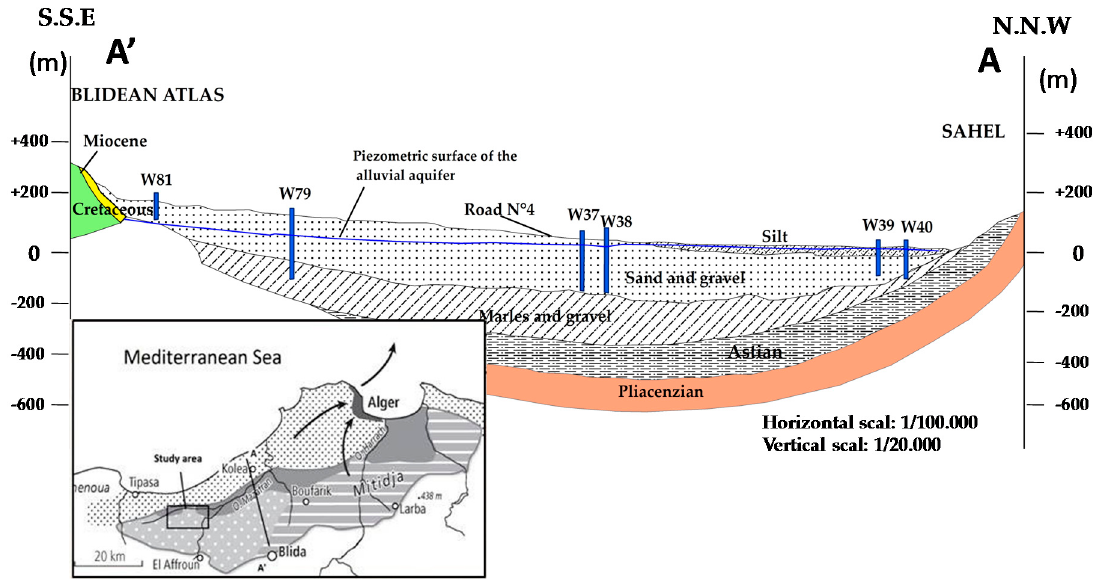
Figure 3. The geological map of the study area.